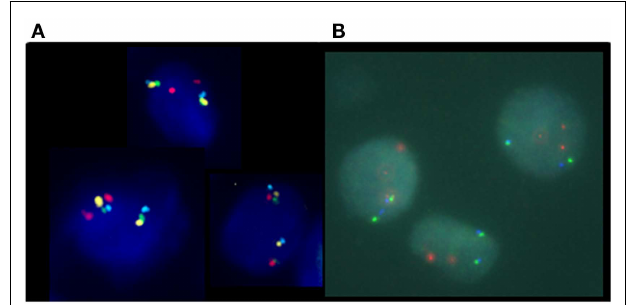
FIGURE 3 | Phosphatase and tensin homolog gene four-color FISH assay . (A) Normal, non-deleted tissue with red signals showing chromosome 10 centromere regions, green signals showing the presence of BMPR1, blue signal showing the presence of FAS, and yellow signal indicating the presence of the PTEN gene; and (B) deleted PTEN locus, the yellow signals corresponding to the PTEN gene are absent indicating homozygous deletion of PTEN.